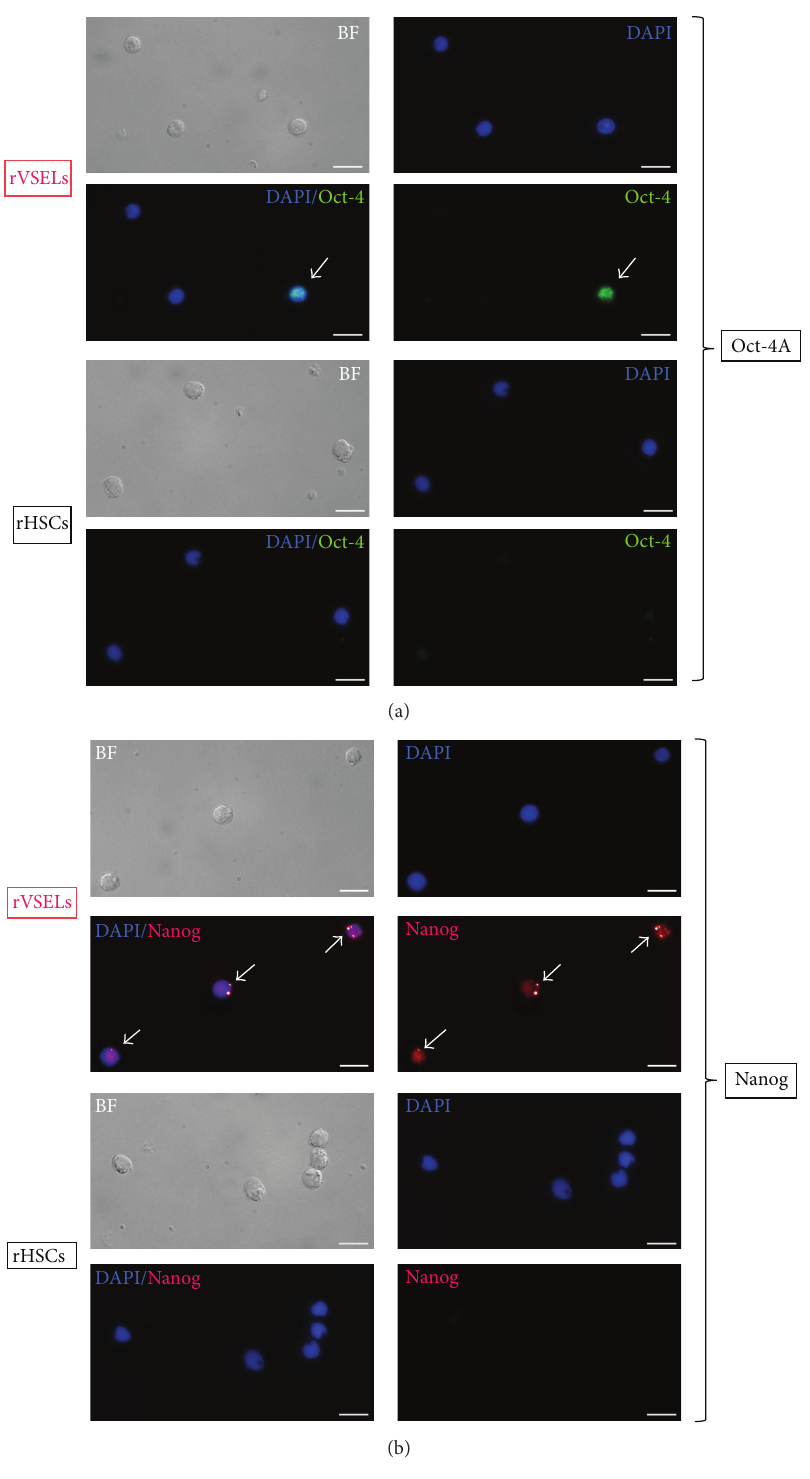
Figure 5: Expression of Oct-4A and Nanog in sorted fractions of rVSELs (CD45 − /Lin − /CD106 + ) and rHSCs (CD45 + /Lin − /CD106 + ) by immunocytochemistry. Both fractions were sorted with MoFlo XDP cell sorter (Beckman Coulter) and further stained for Oct-4A (Alexa Fluor 488, green) (a) or Nanog (Alexa Fluor 546, red) (b) and analyzed with Leica DMI6000B (ver. AF7000) fluorescent microscope. Nuclei are stained with DAPI. Intranuclear staining for both transcription factors is visualized on combo images. The scale bars indicate 10 𝜇